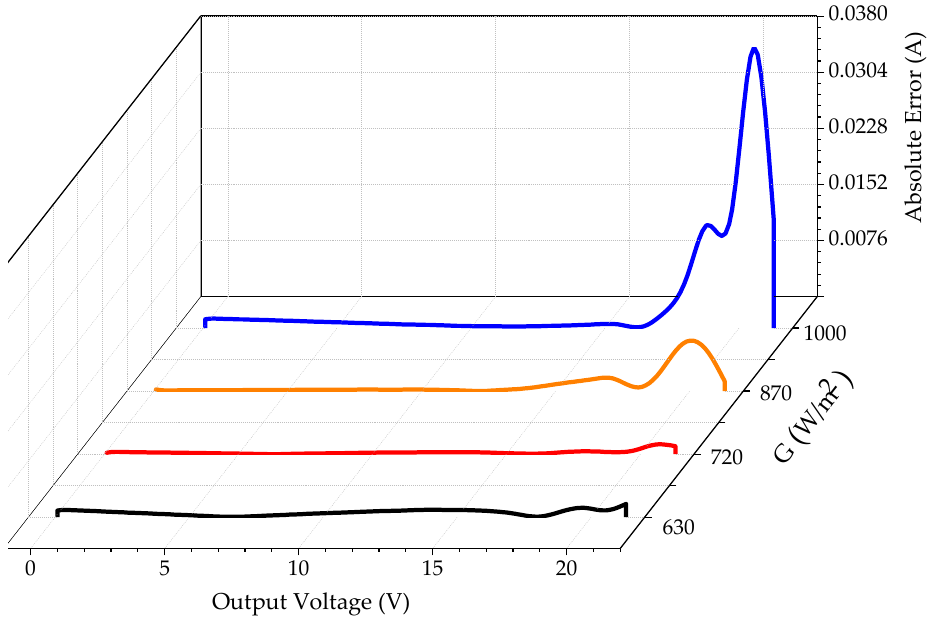
Figure 6. Internal absolute error between measured and simulated current for single-diode model of SS2018P PV module at different level of irradiance.